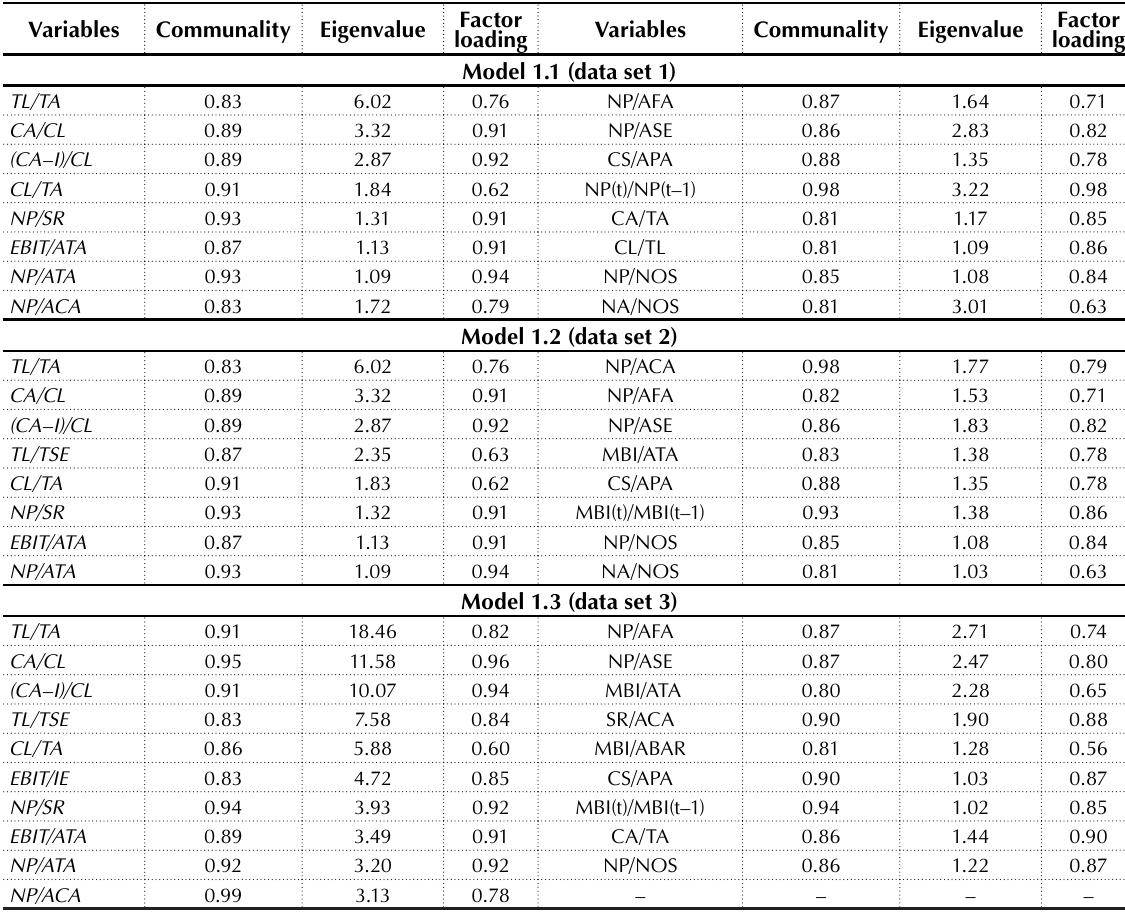
Table A3. Results of factor analysis – variable set 1